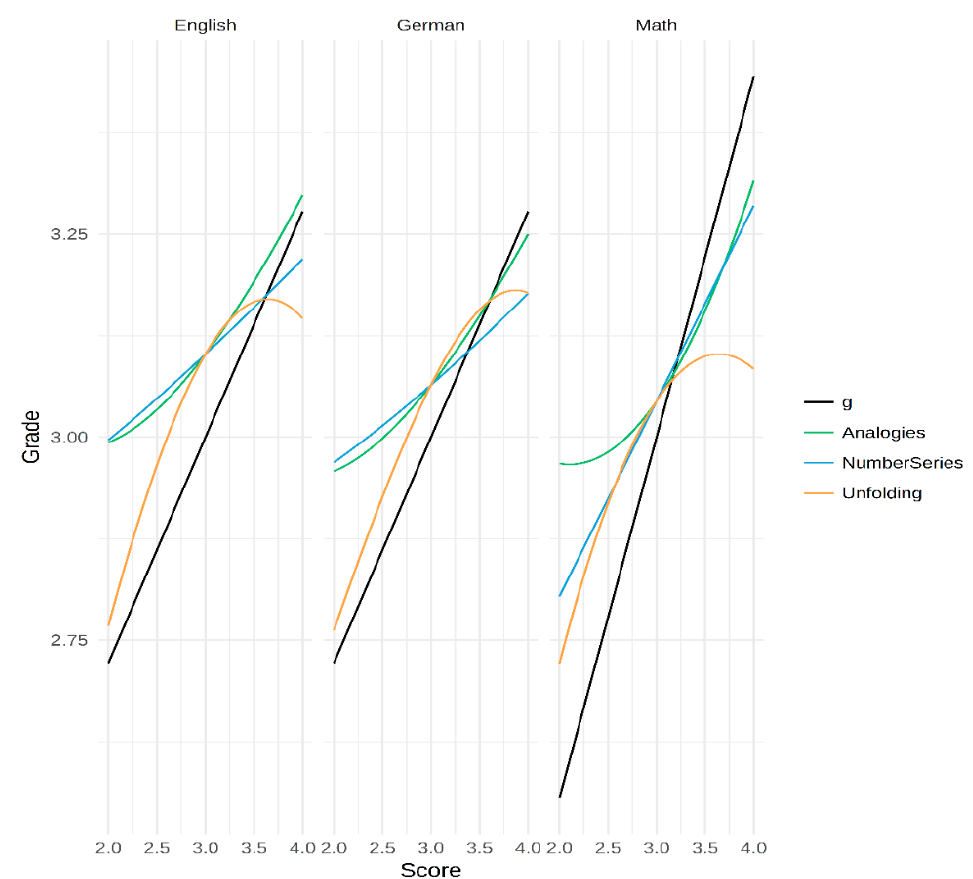
Figure 4. Relation between grades and ability test scores estimated from the selected models. In the case of several predictors, the levels for the respective other predictors were fixed at 3.